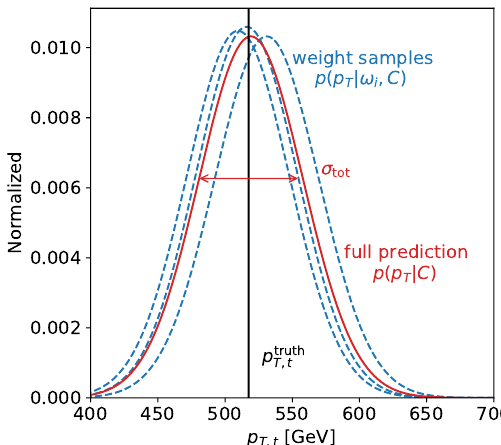
Figure 2: Illustration of the predicted distribution from our Bayesian setup for a single top jet. We show the individual predictions from sampling the weights (petrol) as well as the aggregate prediction (red) and the corresponding per-jet uncertainty σ